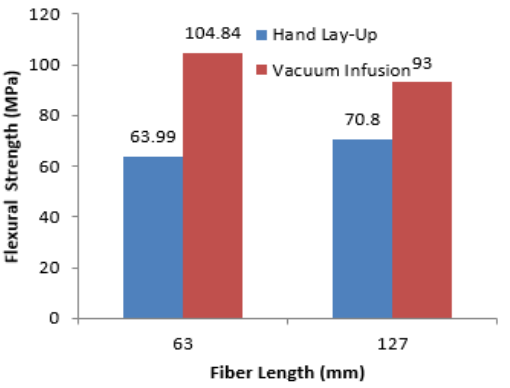
Figure 5: Shows the relationship of volume fraction on flexural strength of specimens with volume fraction